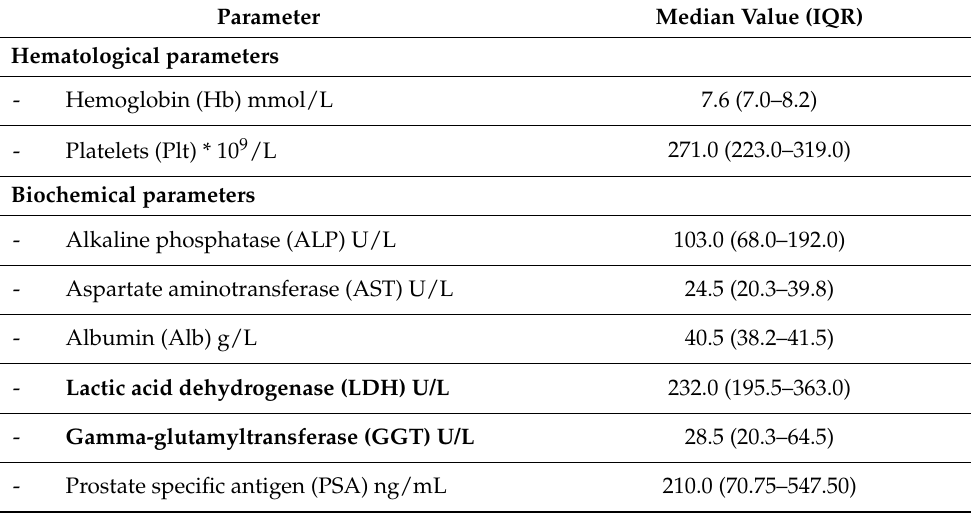
Table A1. Blood results before first [ 177 Lu]Lu-PSMA-617 radioligand therapy.